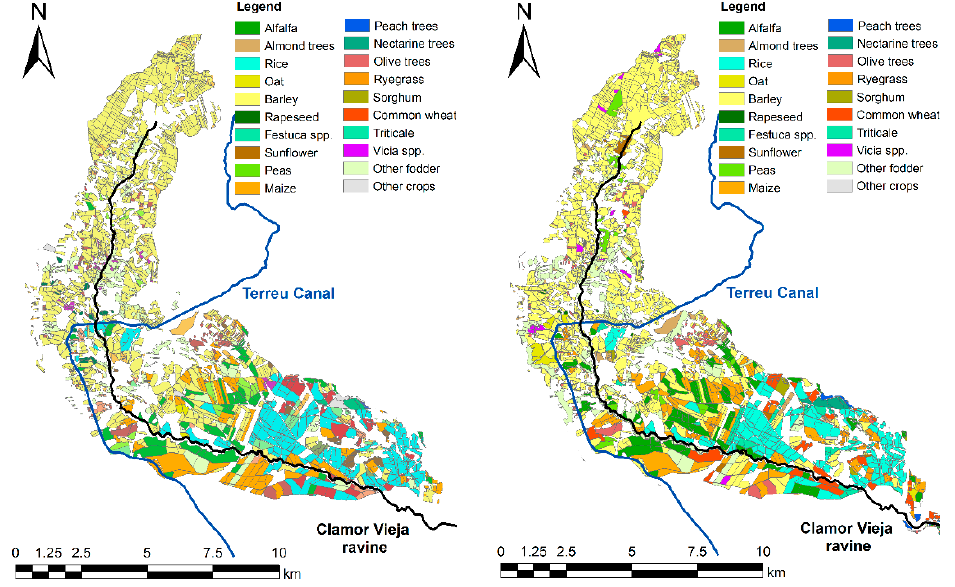
Figure 3. Maps of crops grown in ( left ) 2009 and ( right ) 2010 in the Clamor Vieja basin.